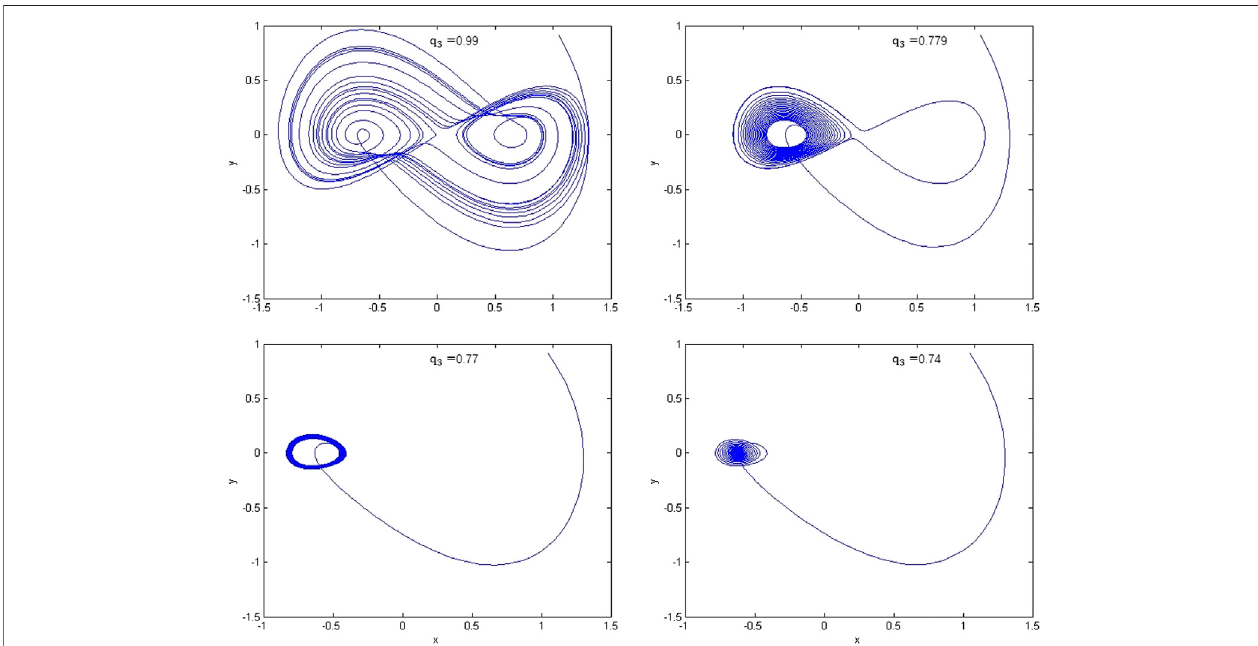
FIGURE 3 | Phase portraits of model Eq. 2.9 with q 1 (cid:1) q 3 (cid:1)